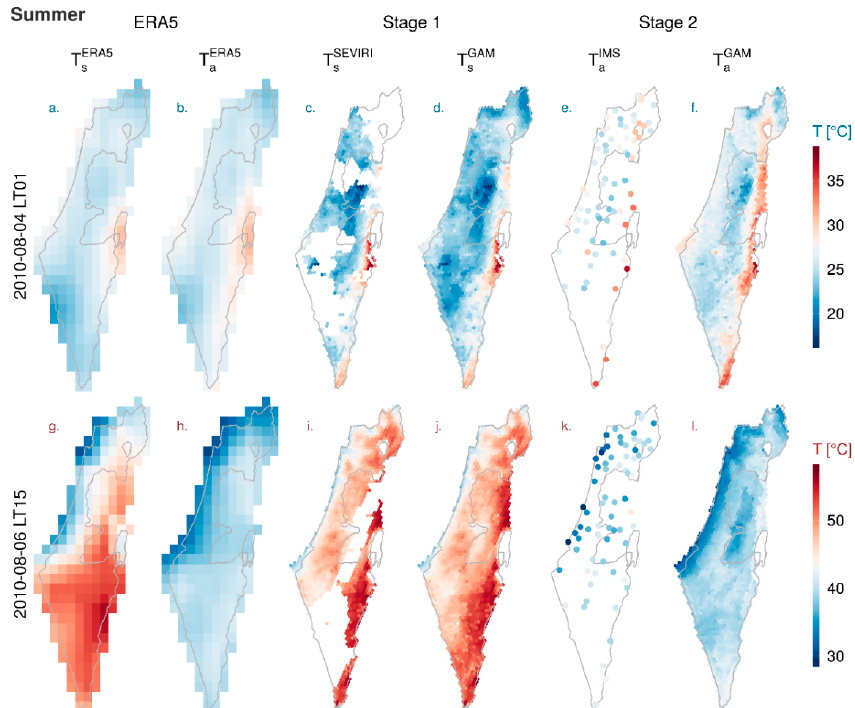
Figure 13. Inputs and outputs of the two-stage model for the nighttime (LT 0100, ( a – f )) and daytime (LT 1500, ( g – l )) hours of a typical summer day (06-08-2010) contrasting baseline input data (Stage 1: Ts, Ta from ERA5, Ts from SEVIRI with gaps; Stage 2: Ta from IMS weather stations), output from Stage 1 (Ts estimated by GAM), and output from Stage 2 (Ta estimated by GAM).